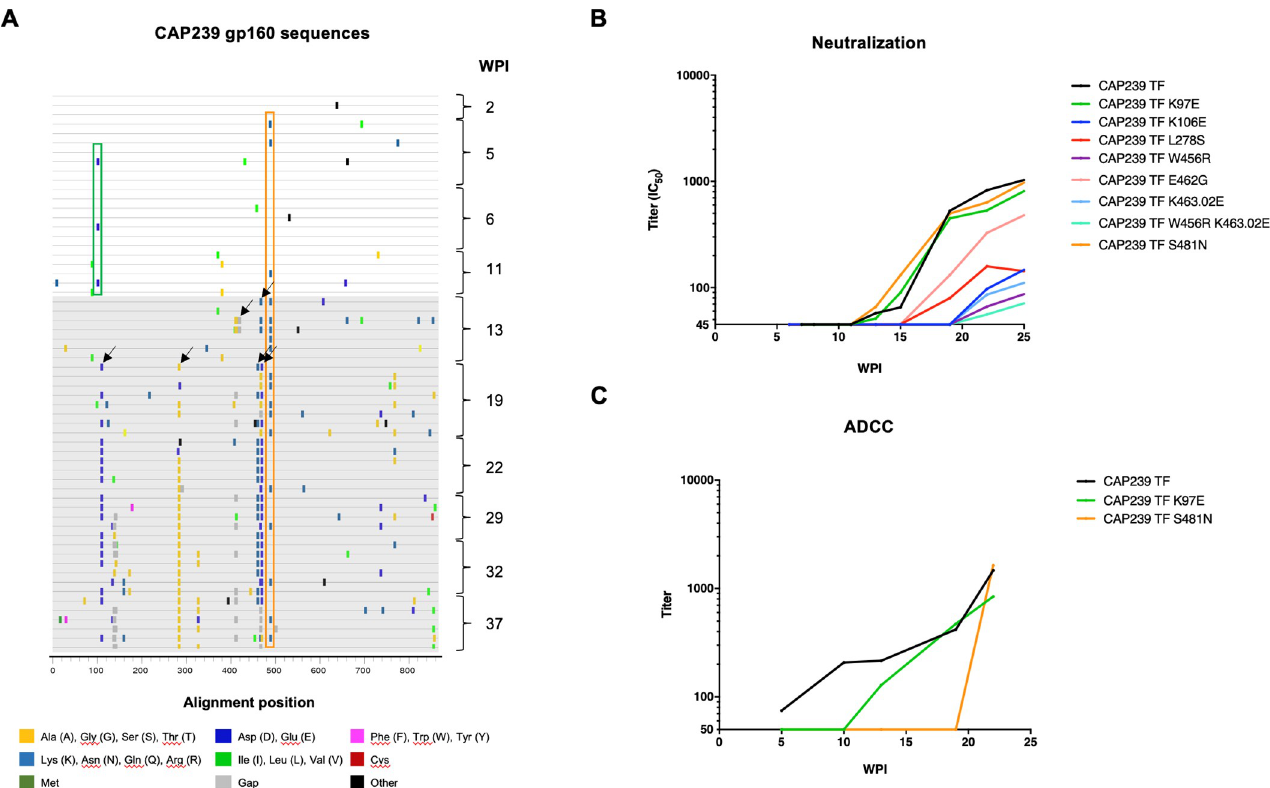
Fig 1. Escape from ADCC and neutralizing antibody responses in CAP239. (A) Highlighter amino acid plot comparing 61 single genome env sequences, generated from 10 time-points over eight months of infection, to the T/F sequence (top line). The two sites that were evolved prior to nAb responses, and occurred in multiple sequences, are shown as boxes: K97E (green box), and S481N (orange box); and the eight sites/combination sites that evolved after nAb responses, and occurred in multiple sequences, are as arrows (K97E, K106E, L278S, W456R, E462G, K463.02E, S481N, W456R K463.02E). (B) Neutralization titers (IC 50 ) of longitudinal autologous plasma evaluated against pseudoviruses: CAP239 T/F env , and 10 CAP239 T/F with sites/combination sites which evolved after nAb responses developed. (C) ADCC antibody titers against infected targets cells in the Luciferase ADCC assay. Cells were infected with T/F virus, as well as the T/F virus with K97E or S481N incorporated. These viruses were used to infect CEM.NKR CCR5 as targets and utilized with donor PBMCs as effectors. WPI indicates weeks post infection. Points on ADCC and neutralisation plots indicate the mean of � three independent experiments.